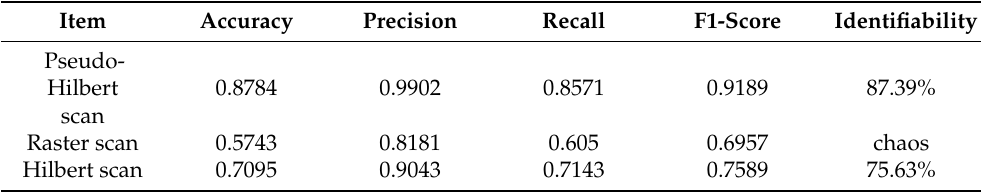
Table 5. Performance comparison based on result analysis and